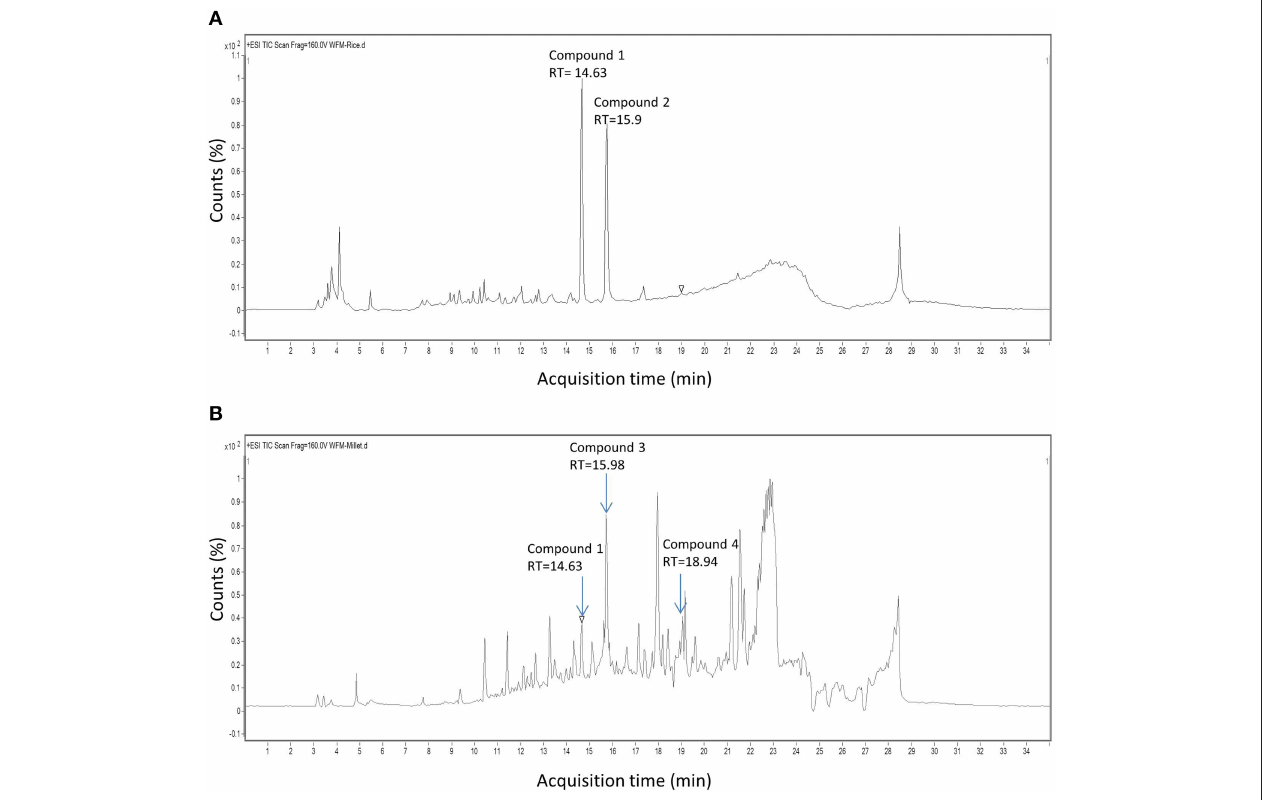
FIGURE 4 | HPLC chromatograms of extracts derived from endophyte WF4. Shown are chromatograms when the endophyte was cultured on (A) rice medium and (B) millet medium. The arrows show the retention time of peaks exhibiting antifungal activity.